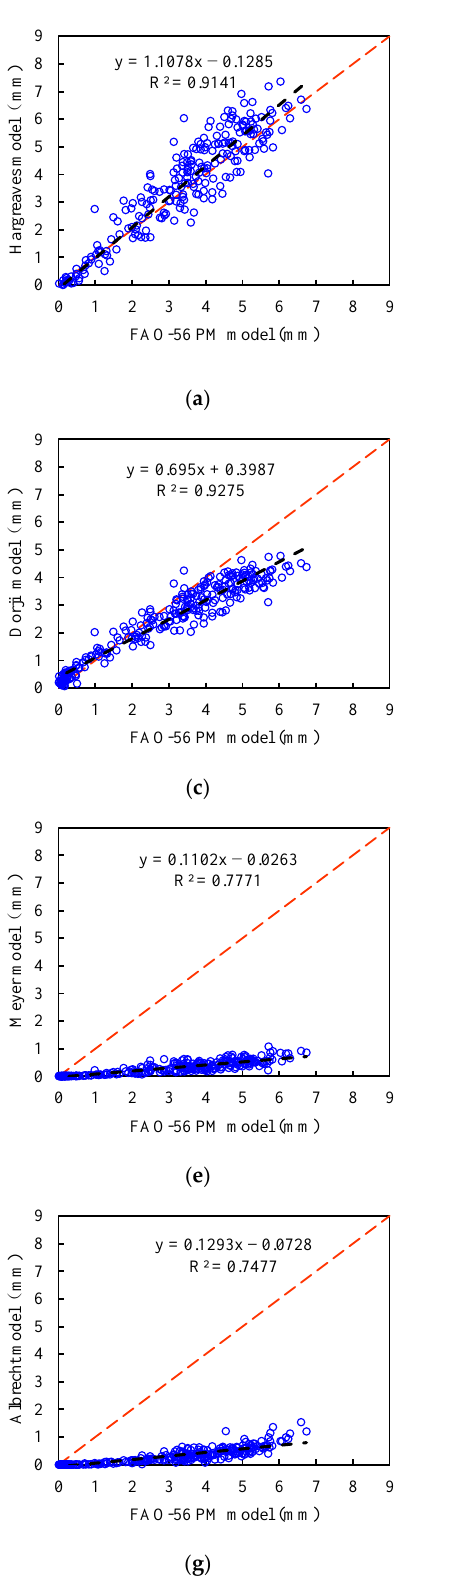
Figure 5. Comparisons of the daily reference evapotranspiration ( ET 0 ) values calculated by the FAO − 56 PM method vs. modelled data via the seven empirical models, including the Hargreaves model ( a ), Berti model ( b ), Dorji model ( c ), Dalton model ( d ), Meyer model ( e ), WMO model ( f ) and Albrecht model ( g ).